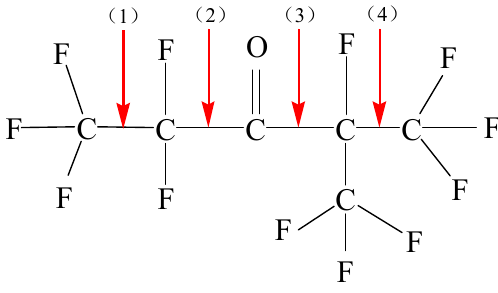
Figure 6. Schematic of the C 6 F 12 O bond breaking.